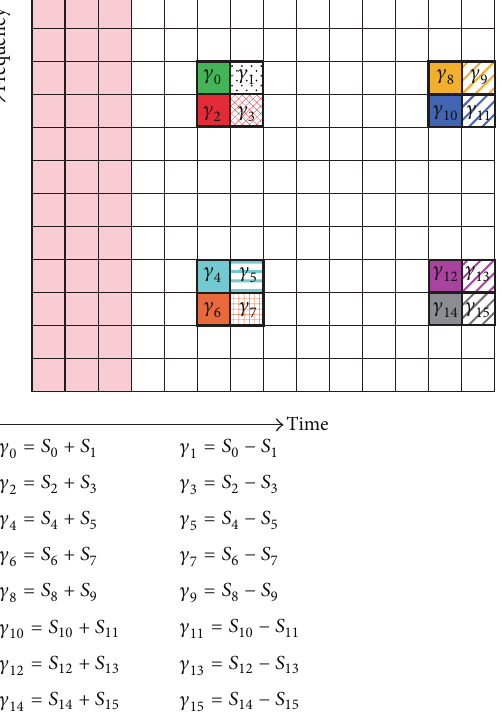
Figure 6: The configuration of long-term CSI-RS in